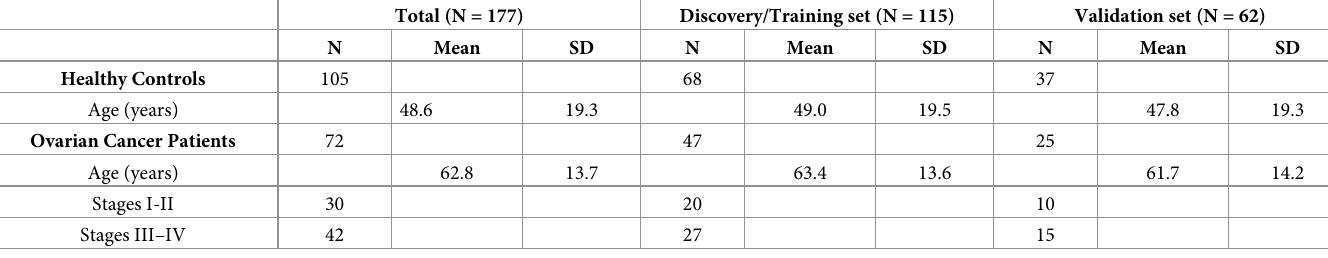
Table 1. Characteristics of the patients and healthy controls in discovery/training and validation